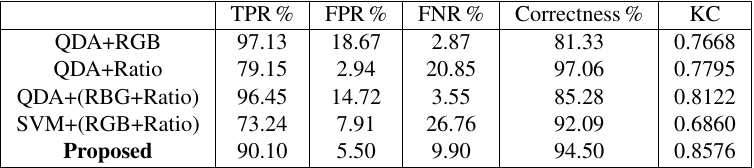
Table 1. The shadow detection results for different classifications on Amersfoort